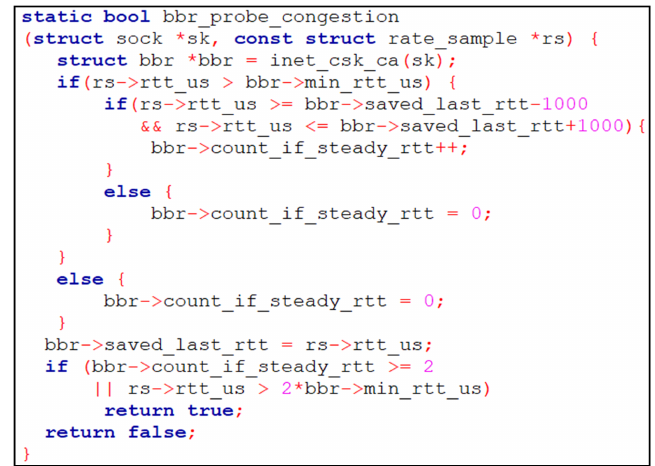
Figure 6. Linux Kernel code of the proposed bbr_probe_congestion() function. Here, α = 1000 µ